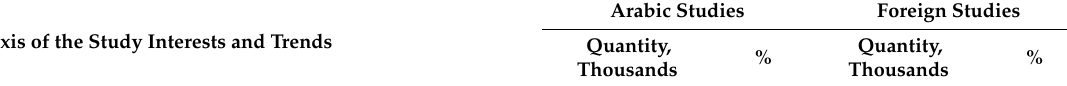
Table 2. Axis-wise distribution of the studies as per different research